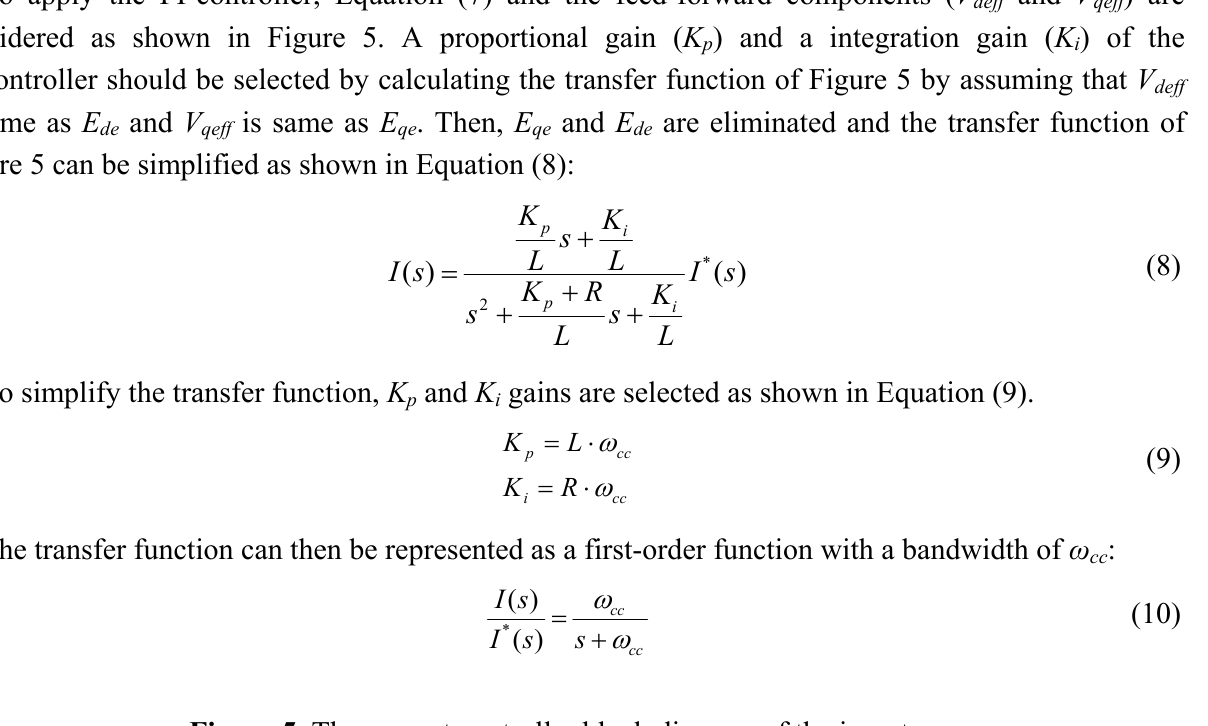
Figure 5. The current controller block diagram of the